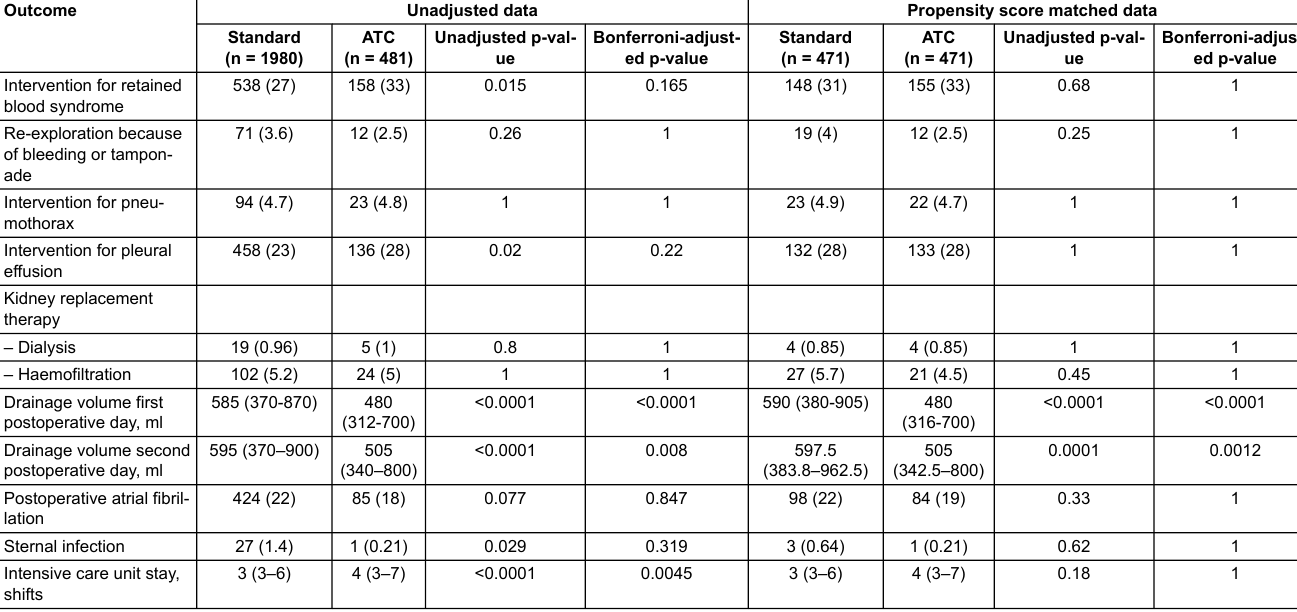
Table 2: Postoperative outcomes. Outcome Unadjusted data Propensity score matched data Standard ATC Unadjusted p-val- (n = 1980) (n = 481)